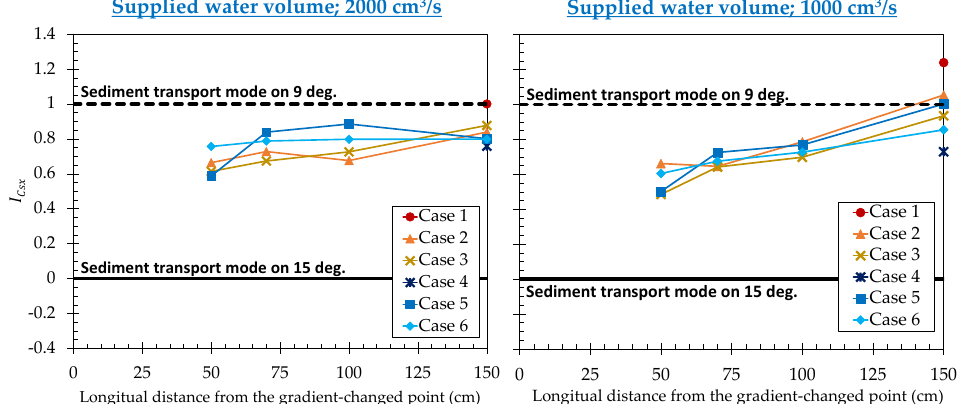
Figure 3. Transition indices of sediment transport modes based on sediment transport concentrations of the “frontal part” of the debris flow, 𝐼 𝐶𝑠̅̅̅𝑥 , for all cases with two inflow rates. Thus, by using the transition indices, 𝐼 𝐶𝑠̅̅̅𝑥 , we can explicitly describe the tendencies